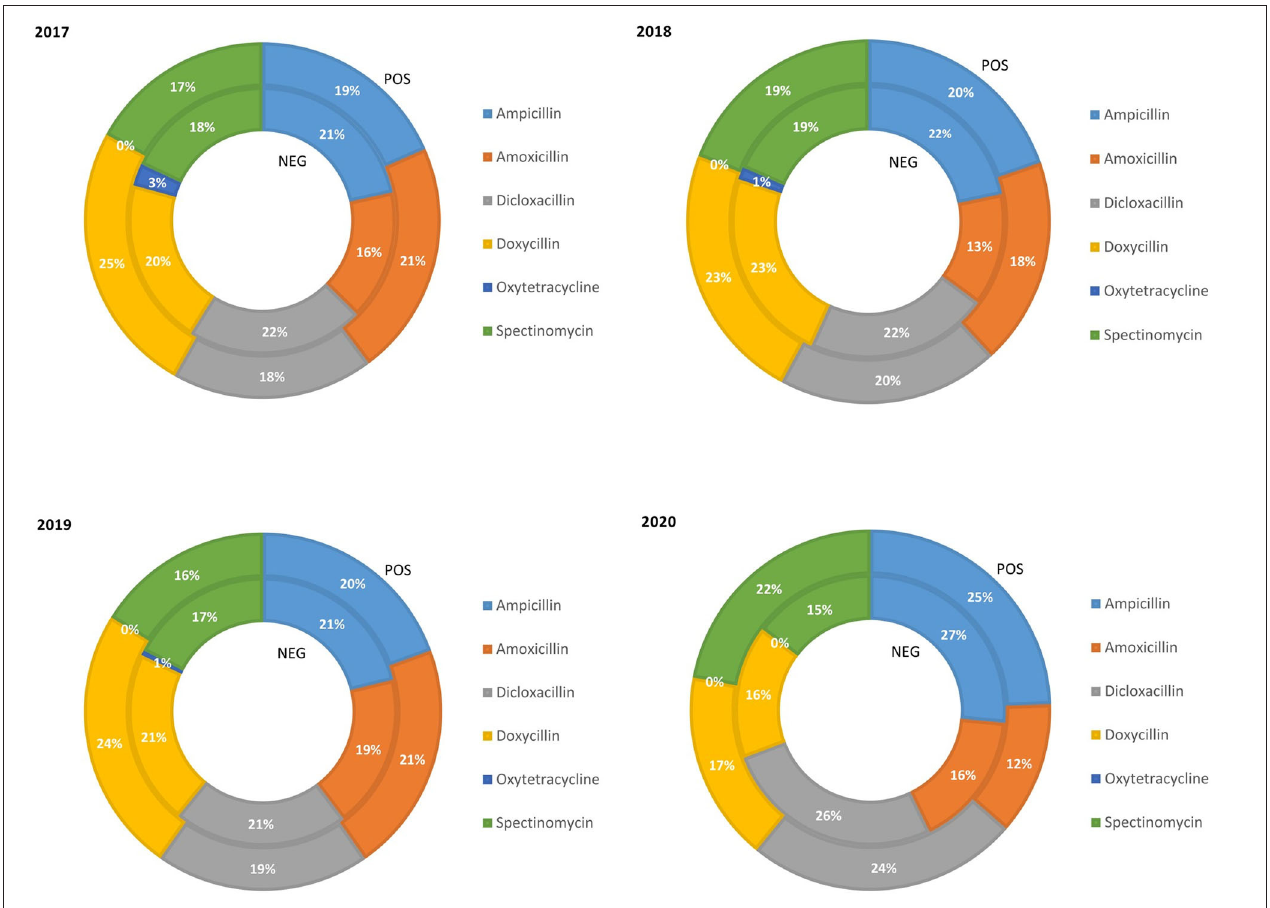
FIGURE 4 | Relative quantity of fattening pig weight treated with class D antibiotics in the PRRS negative (NEG) and PRRS positive (POS) production chains from 2017 to 2020.